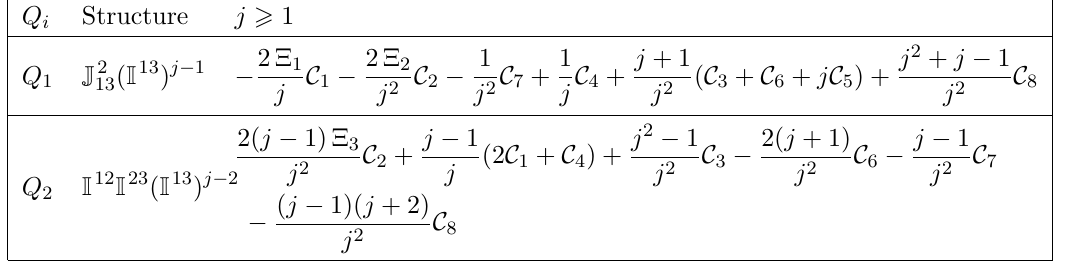
( QO ) J ( QO ) when QO h i